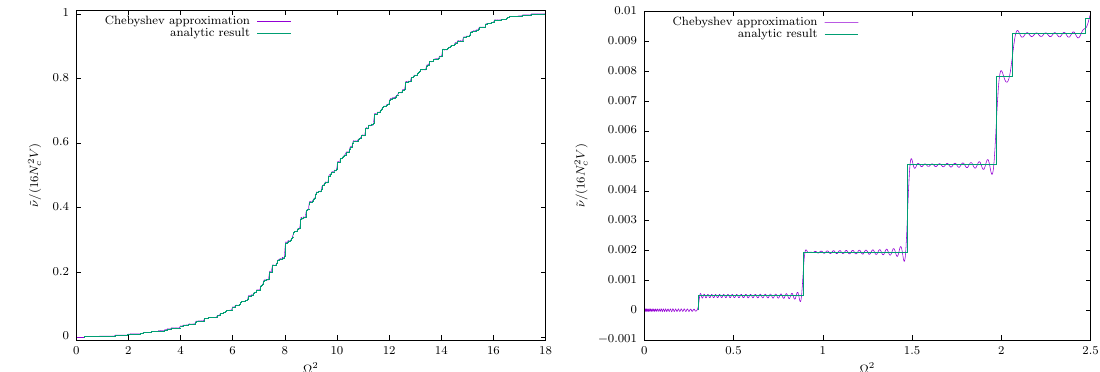
Figure 1. Free-theory mode number analytic result and Chebyshev approximation for lattice volume V = 8 4 with N c = 2 and antiperiodic BCs, the latter using N p = 1000 and N s = 10 estimators. The right plot zooms in on Ω 2 ≤ 2 . 5 to show the stepwise behavior more clearly. Both plots normalize the mode number by the total number of eigenvalues, 16 N 2